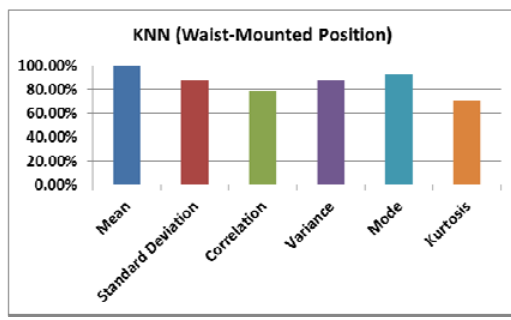
Fig. 7. Comparison of data features